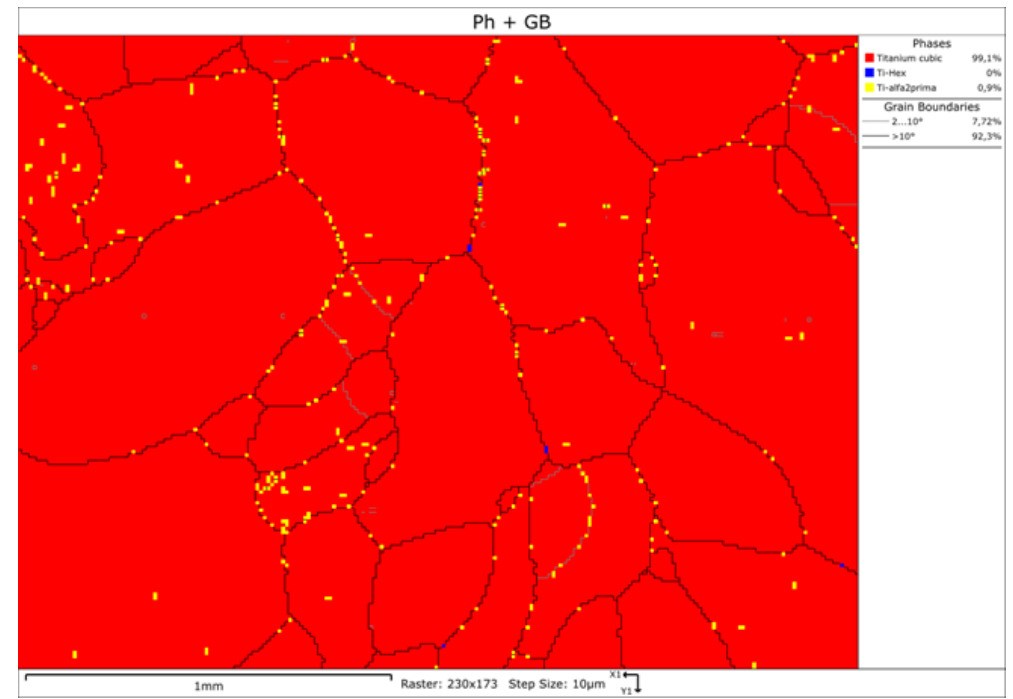
Figure 5. Phase-contrast image by EBSD analysis of as-cast TNZT.